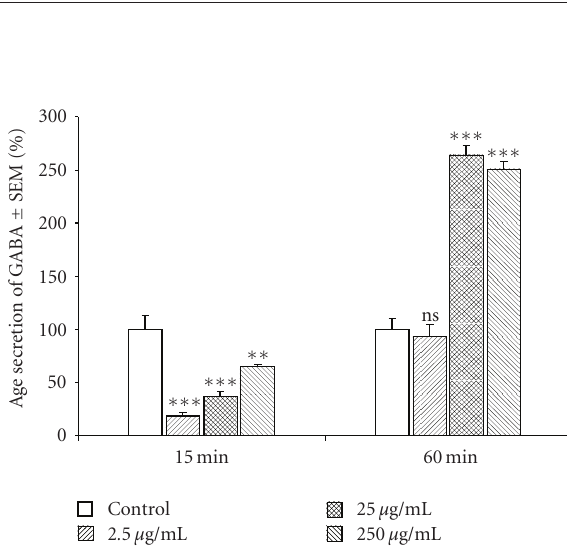
Table 1: Amino acids composition of methanolic extract of Nigella sativa . The results are expressed as pmoles of each amino acid by mg of methanolic extract, prepared under the conditions indicated in experimental procedures. Amino acid Asp Glu Gly GABA pmoles/mg NS Methanolic extract